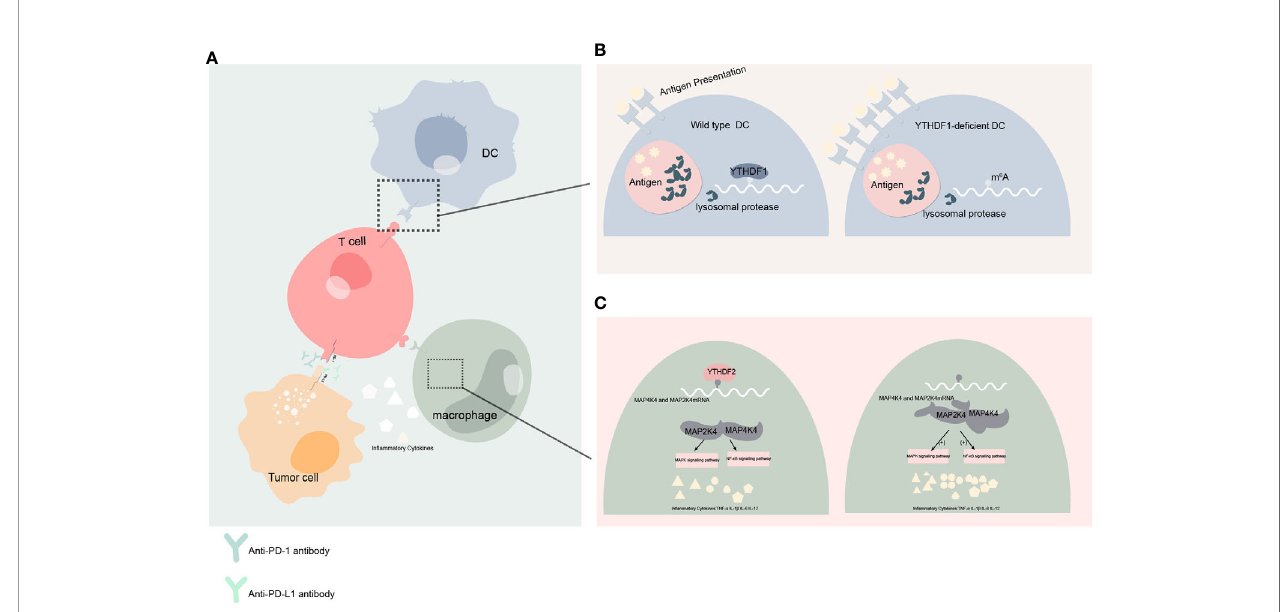
FIGURE 3 | Effect of YTHDFs on tumor immune microenvironment (TIME) (A) Dendritic cells (DC) presents the antigen to the surface of T cells and initiates the adaptive immune response. Programmed cell death protein 1 (PD-1)/programmed death-ligand 1 (PD-L1) is a negative immune checkpoint pathway that inhibit immune responses and promotes immune escape of tumor cells. This process can be blocked by anti-PD-1/PD-L1 antibodies. Macrophages can affect anti-tumor immunity by secreting in fl ammatory factors. (B) When YTHDF1 is de fi cient, the translation ef fi ciency of lysosomal protease transcripts decreases, the degradation of antigens is reduced, more antigens are involved in antigen presentation, and the immune response of T cells is enhanced. This process may affect the ef fi cacy of PD- L1 checkpoint inhibitors. (C) In macrophages, YTHDF2 knockdown promotes the translation and stability of MAP2K4 and MAP4K4 mRNA, which activates MAPK and NF- k B signaling pathways and promotes the expression of pro-in fl ammatory cytokines. These in fl ammatory factors can participate in the regulation of immune response and affect the ef fi cacy of anti-tumor